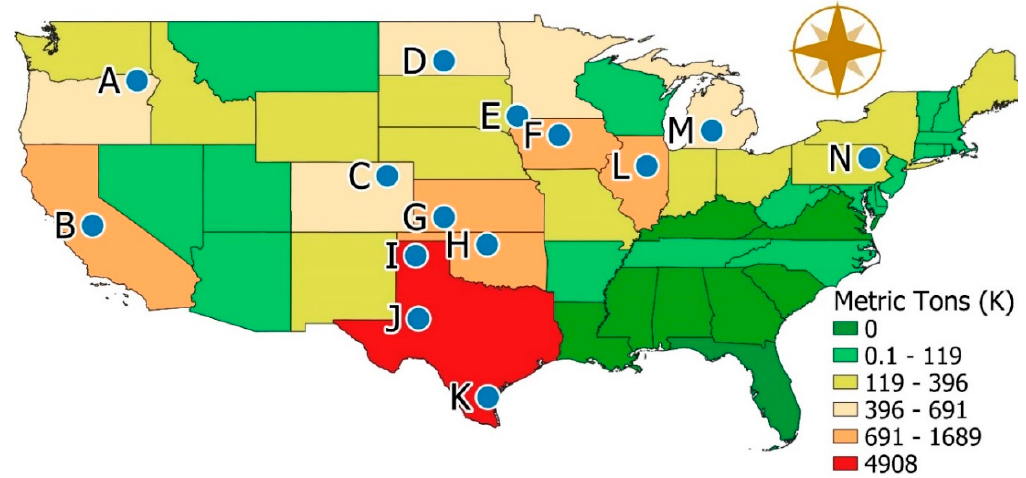
Figure 10. Proposed wind turbines end-of-life (EoL) centers in the continental US.